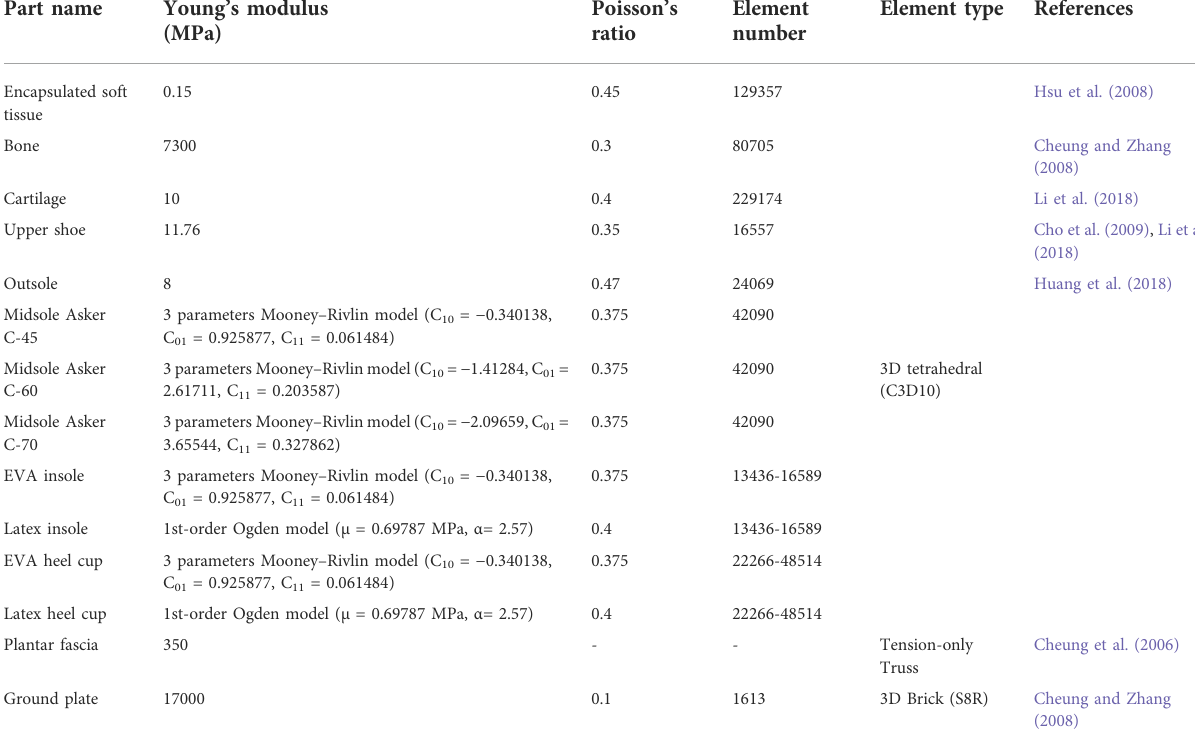
TABLE 1 Material properties in FE